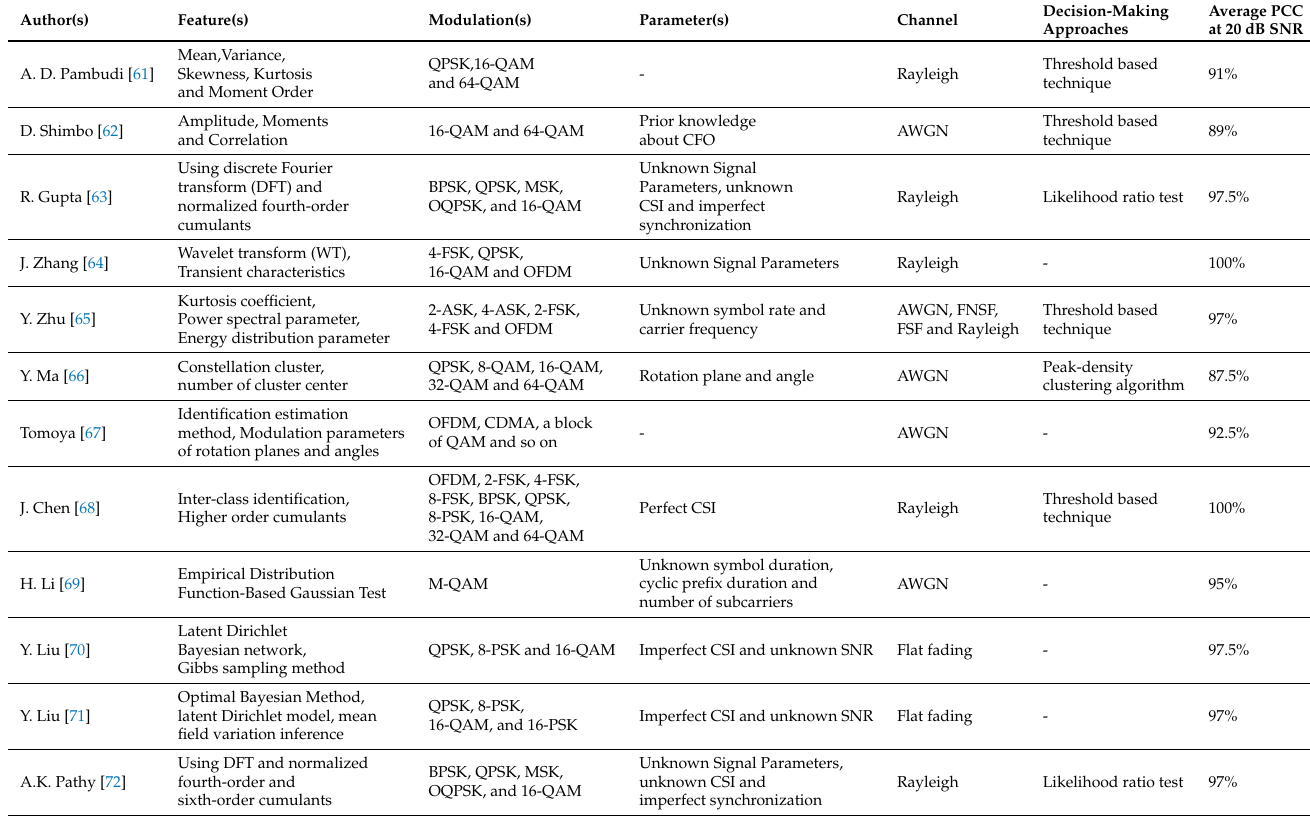
Table 4. Summary of FB approaches for OFDM